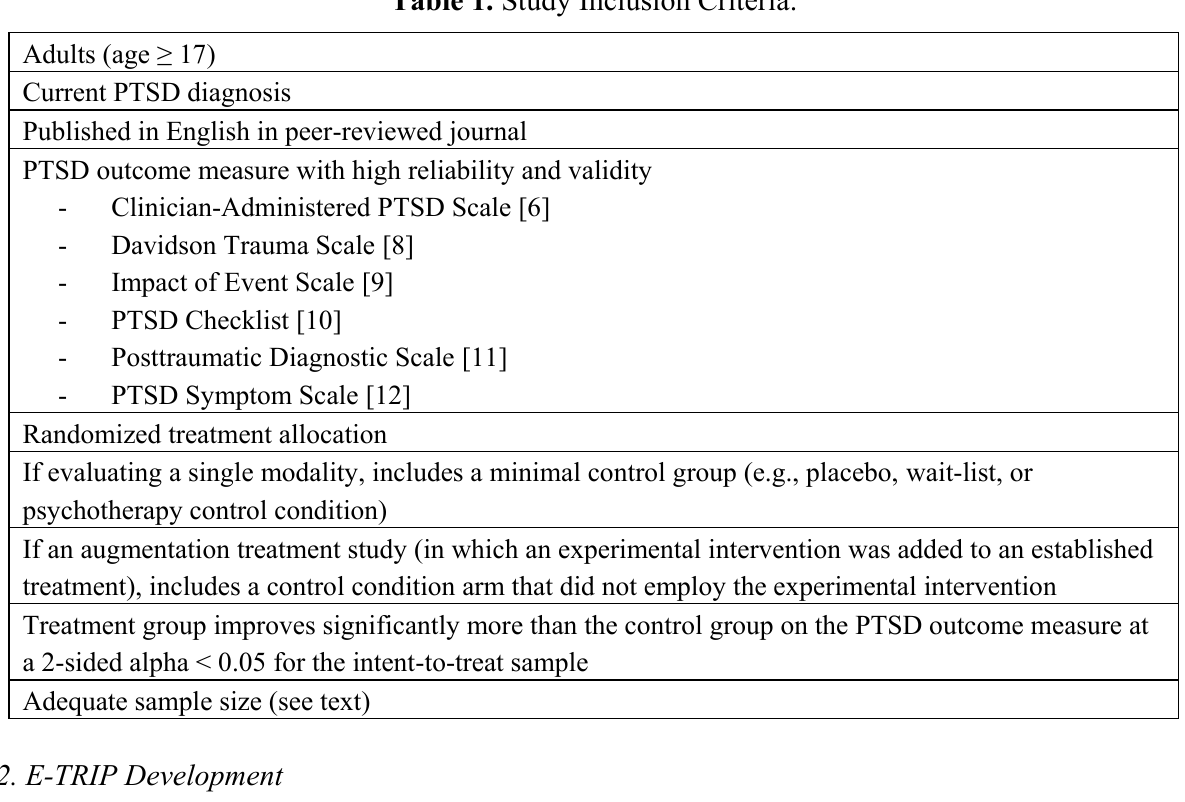
Table 1. Study Inclusion